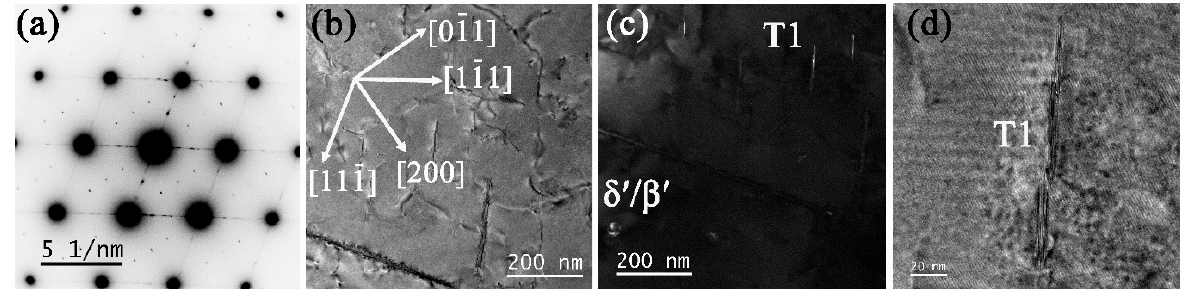
Figure 13. TEM analysis of 6A# after 12 h creep. ( a ) SADP under [110] α . ( b ) BF and ( c ) DF of ( b ). ( d ) BF of an enlarged secondary T 1 phase.